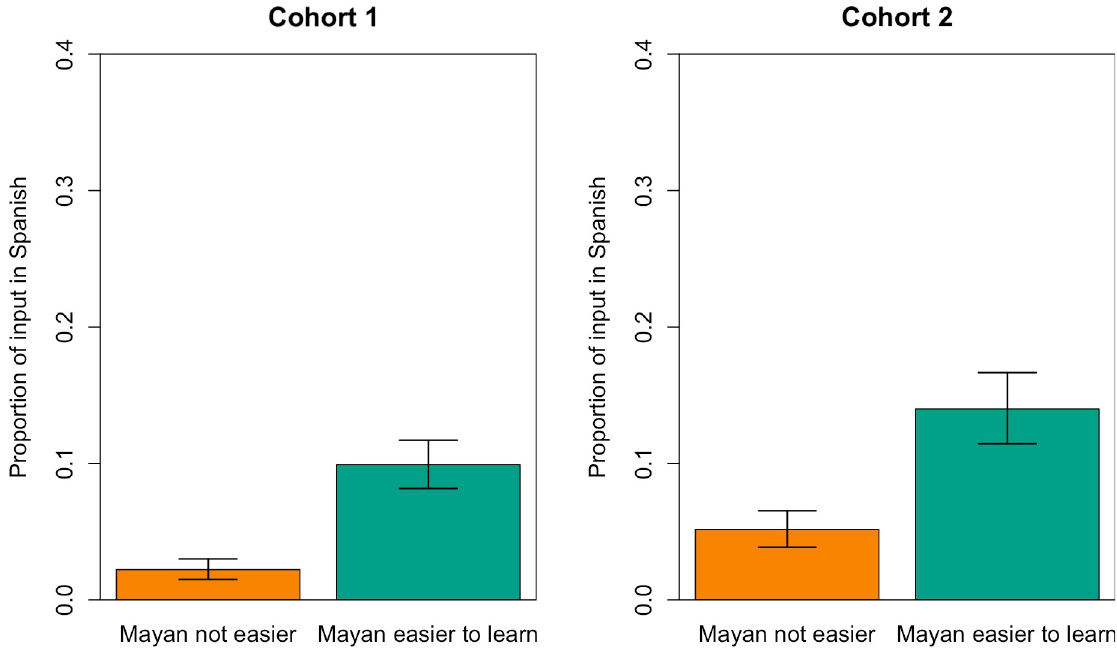
Fig 3. Posterior means (bars) and 90% HPDI (error bars) for the models predicting the proportion of utterances in Spanish (Number of directed utterances in Spanish out of the total number of directed utterances) primary caregivers directed to their infants in Cohort 1 (left) and Cohort 2 (right) according to whether they believed Yucatec Maya was learnt easier/faster than Spanish or not.